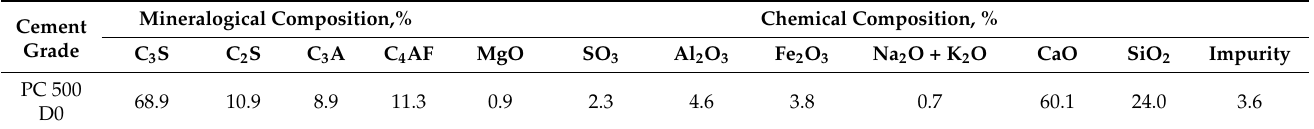
Table 2. Mineralogical and chemical composition of Portland cement.